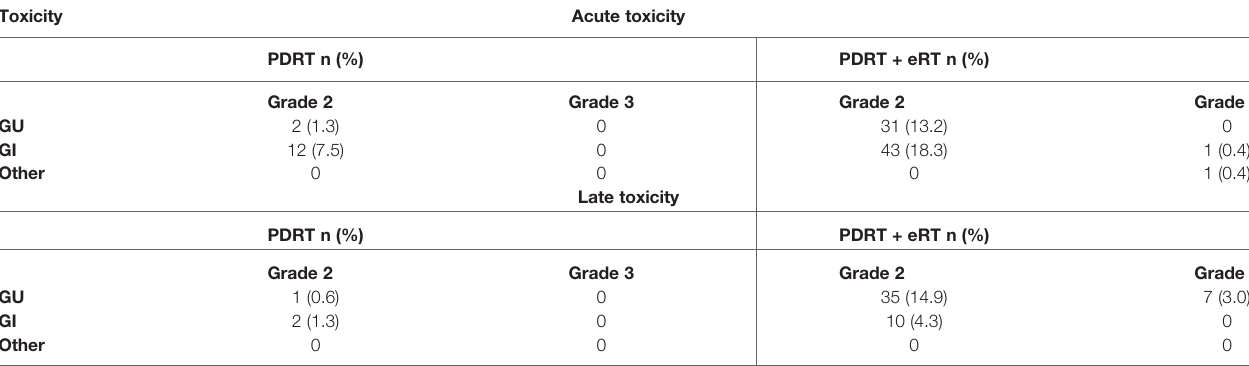
TABLE 4 | Acute and late GI and GU toxicity ( ≥ grade 2) by treatment volume concept according to CTCAE v4.03.